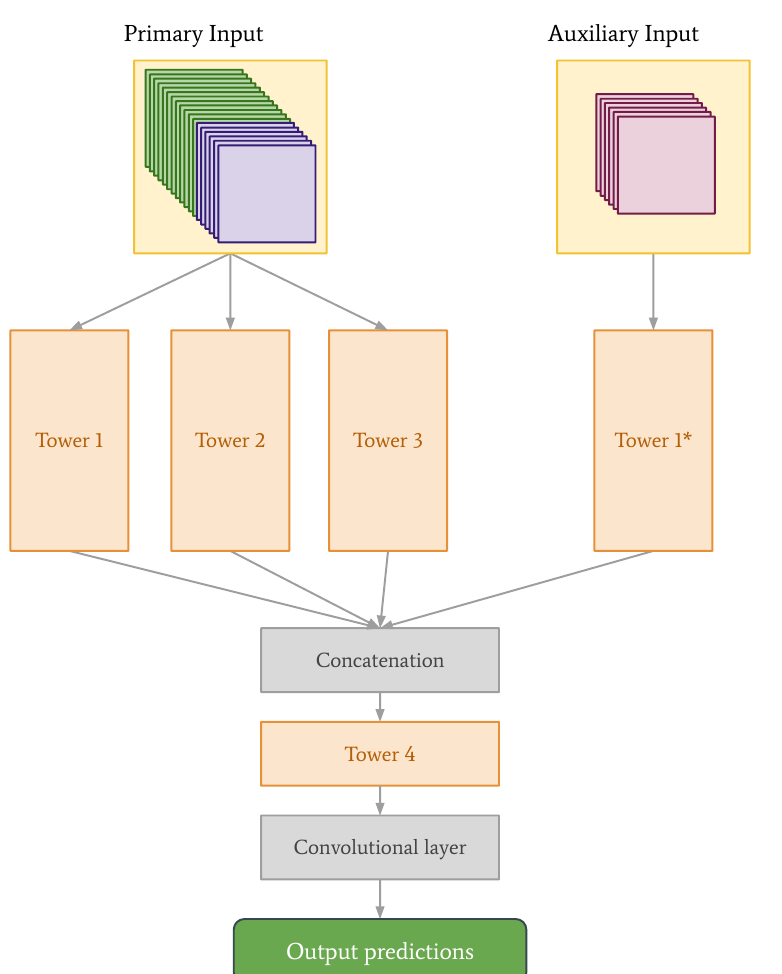
Figure 8. Network architecture for the tower network with primary input made up of stacked observational and NWP data (40 × 40 × 18), and auxiliary input made up of land area fraction and altitude from the observations and NWP data set, as well as sine and cosine values corresponding to day of the year mapped to values between 0 and 2 π (40 × 40 × 6). The construction of a tower remains the same as what is shown in Figure 2.